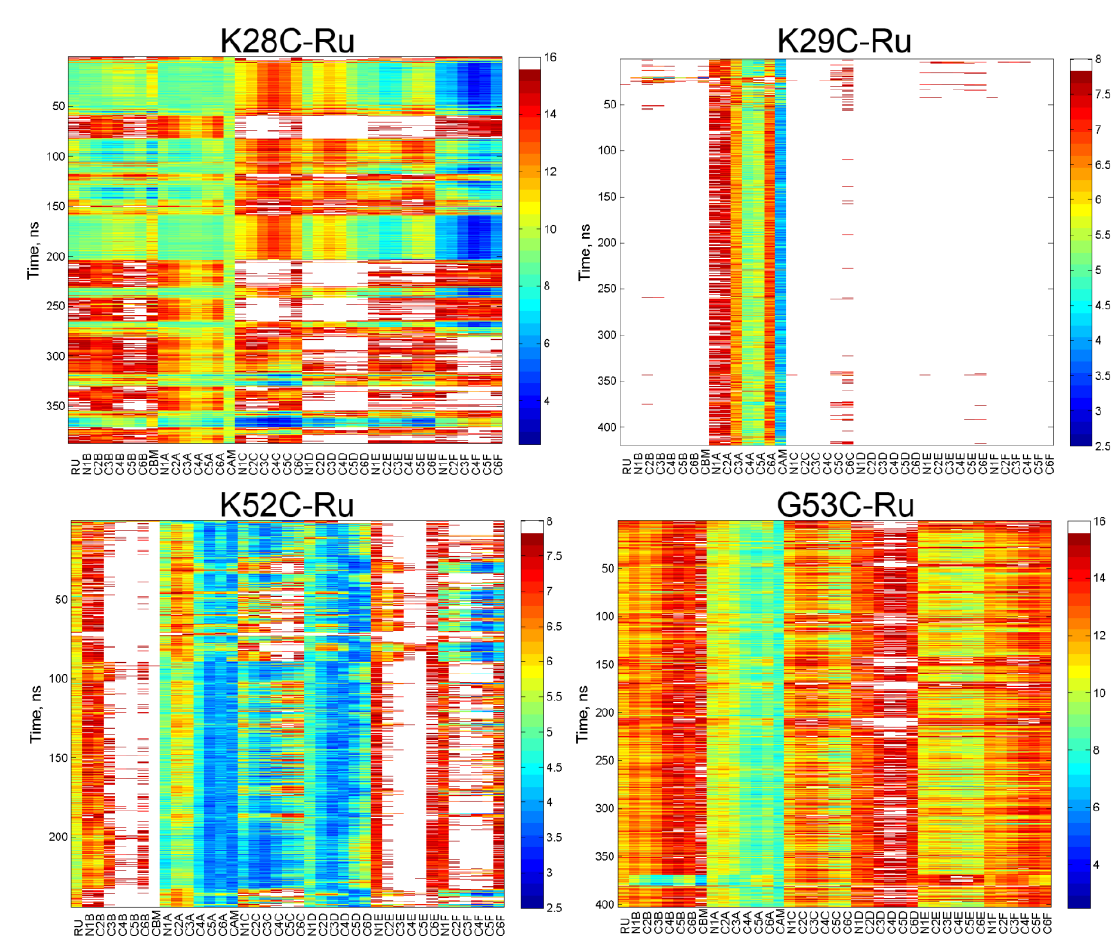
Figure 5. Shortest distances between photosensitizer atoms (x-axes) and closest aromatic atoms of PpcA hemes from representative MD simulations (time on y-axes) with distances coded according to the color bars on the right of each panel.